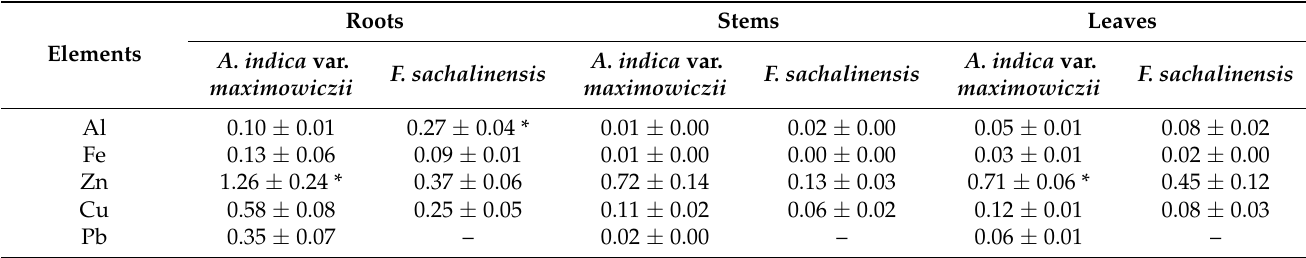
Table 4. Bioconcentration factors (BCFs) of elements in A. indica var. maximowiczii and F. sachalinensis .